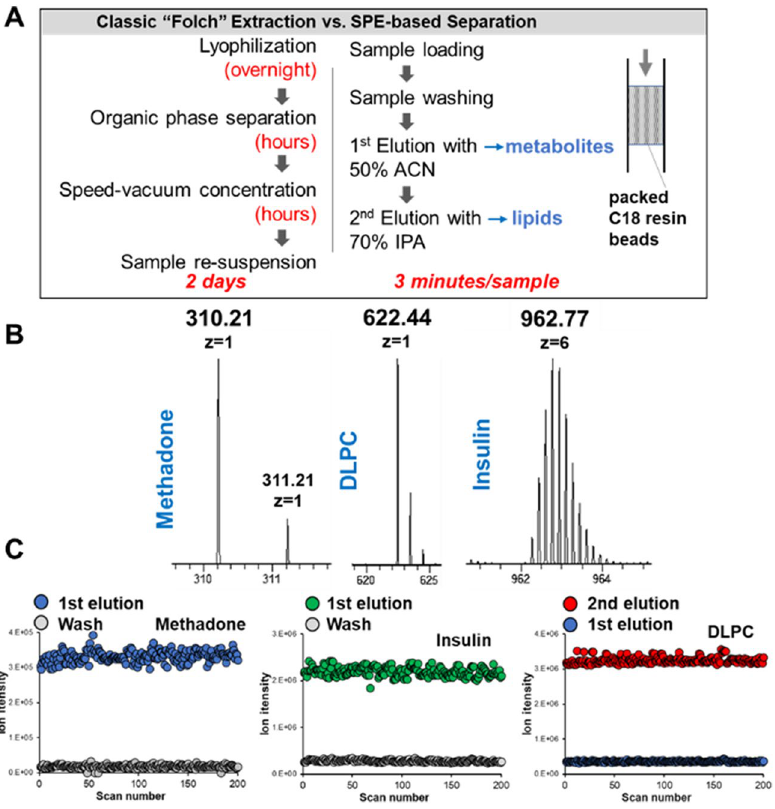
Figure 2. Method development for the separation of small molecules and lipids from one sample using duel mobile phase solvents. ( A ) Comparison between the classic Folch method and the solid-phase extraction (SPE)- based method developed in this work, which incorporates dual-mobile phase extraction. ( B ) Mass spectra of three representative molecules were used to validate the dual-mobile phase extraction method. ( C ) Recorded ion intensities of three representative molecules in either washing or eluting